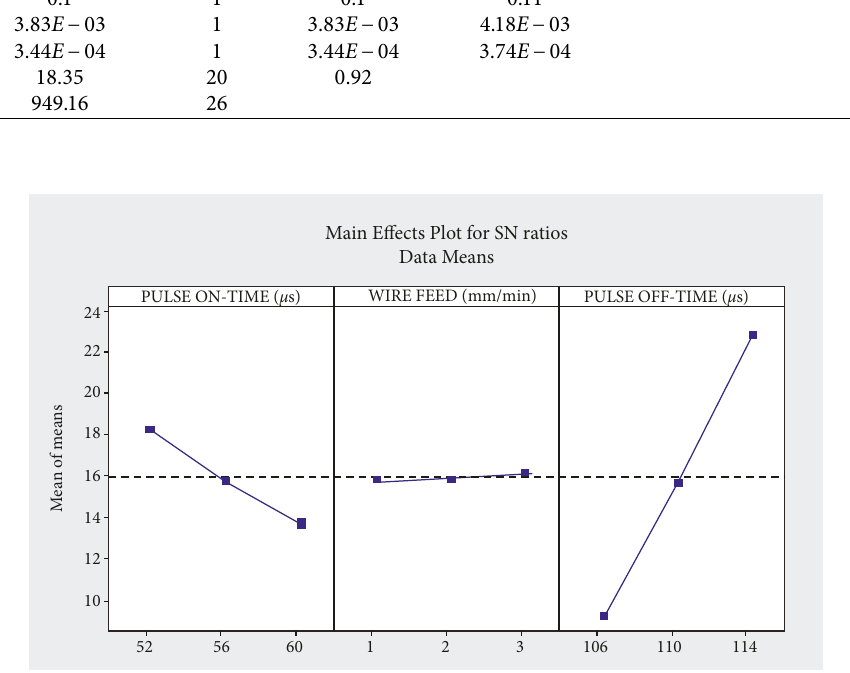
Figure 19: Main effects plot for